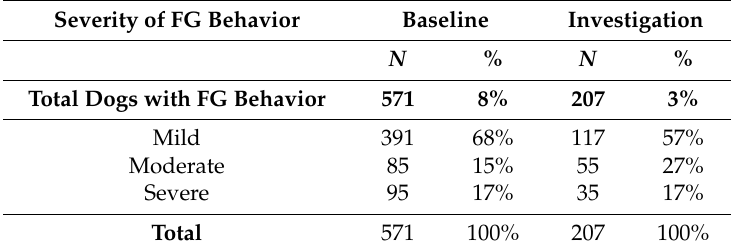
Table 1. Severity of Food guarding (FG) behavior identified in all FG dogs comparing the baseline (8%, 571/7112) and investigation (3%, 207/7068) phases. There was an overall significant difference in the categories of severity between the baseline and investigative phase ( p = 0.001, X 2 = 14.86, 2 df). In the baseline, 20% of FG was identified by history and 80% by the assessment. During the investigation phase, 71% of FG was identified by history and 29% from shelter